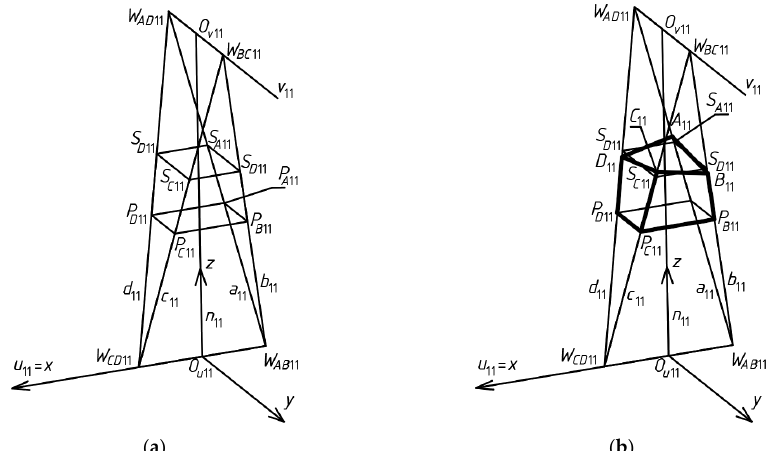
Figure 5. Geometric elements and their denotation used for shaping the first mesh Γ 11 of a polyhedral reference network Γ , the first mesh B v 11 of a quadrilateral eaves network, and the first mesh of the model Σ shaped: ( a ) the essential elements of these networks, ( b ) the obtained first mesh of the model Σ .